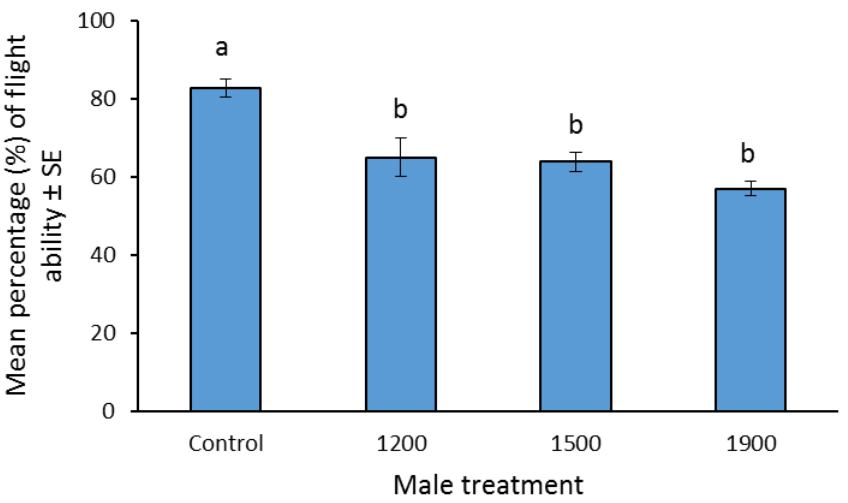
Figure 2. Flight ability of sterilized Aedes albopictus males shipped at different densities and the wild non-shipped, fertile males of the control population. Different letters indicate significant differences (Tukey’s HSD test, p < 0.005).